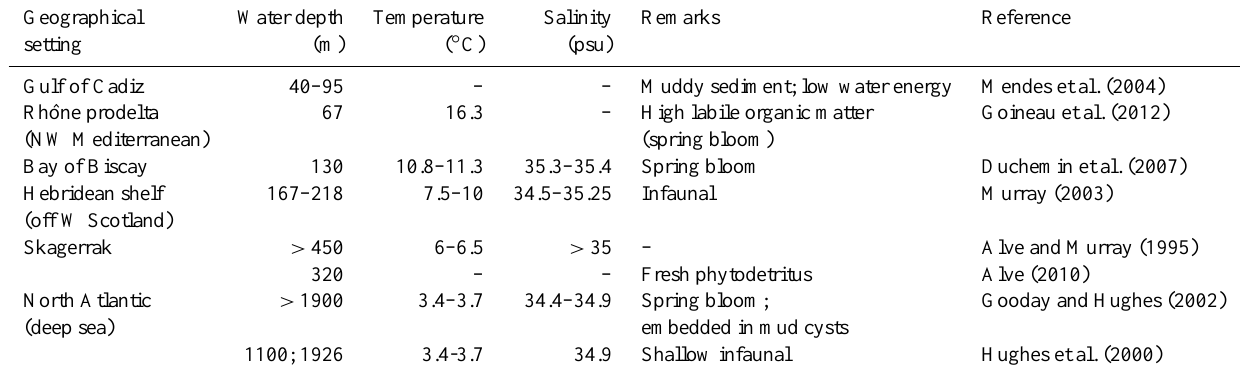
Table 4. The ecological preferences of Nonionella iridea summarised for different settings. The information given in remarks indicates either parameters reported as essential for higher abundances of N. iridea , or refers to microhabitat preferences of this species. Geographical Water depth